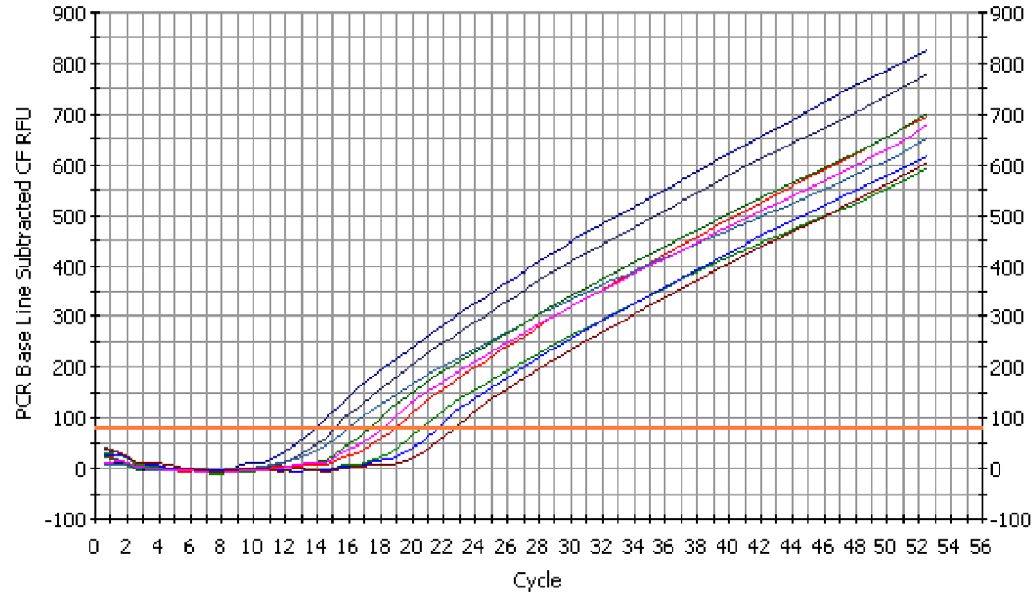
Figure 1. Real-time amplification of a serially diluted known positive sample. PCR base line subtracted curve fit data shows amplification of the Avipoxvirus 4b core protein gene from a 1:2 serial dilution of first reaction PCR product using gDNA from Avipoxvirus culture lysate as template. The threshold for this reaction was 79.0 rfu.